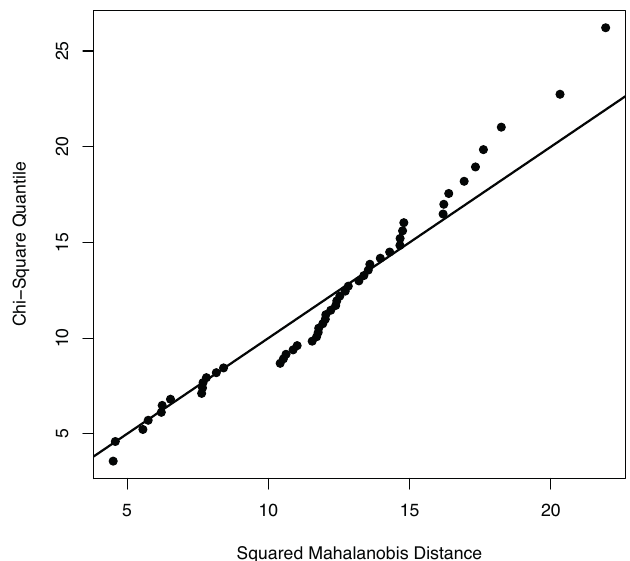
Figure 4. Q − Q plot corresponding to the sample related to fault number 1, using the first twelve principal components. The points in this Q − Q plot are close to the line bisectrix y = x therefore revealing the multivariate normality of the data.